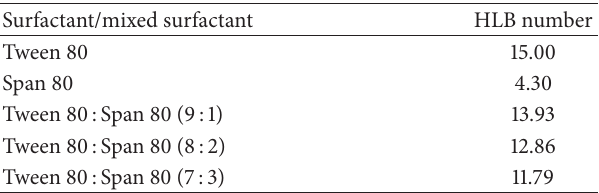
Table 2: Calculated hydrophilic-lipophilic balance (HLB) values of the nonionic surfactants in the single and binary surfactant systems. Surfactant/mixed